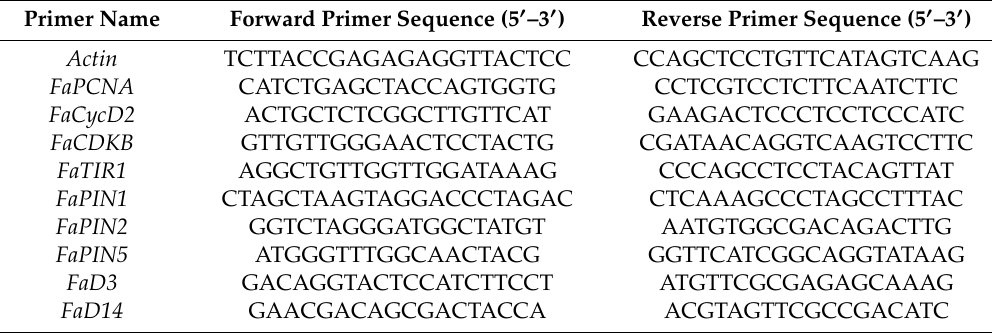
Table 1. Primers used in this